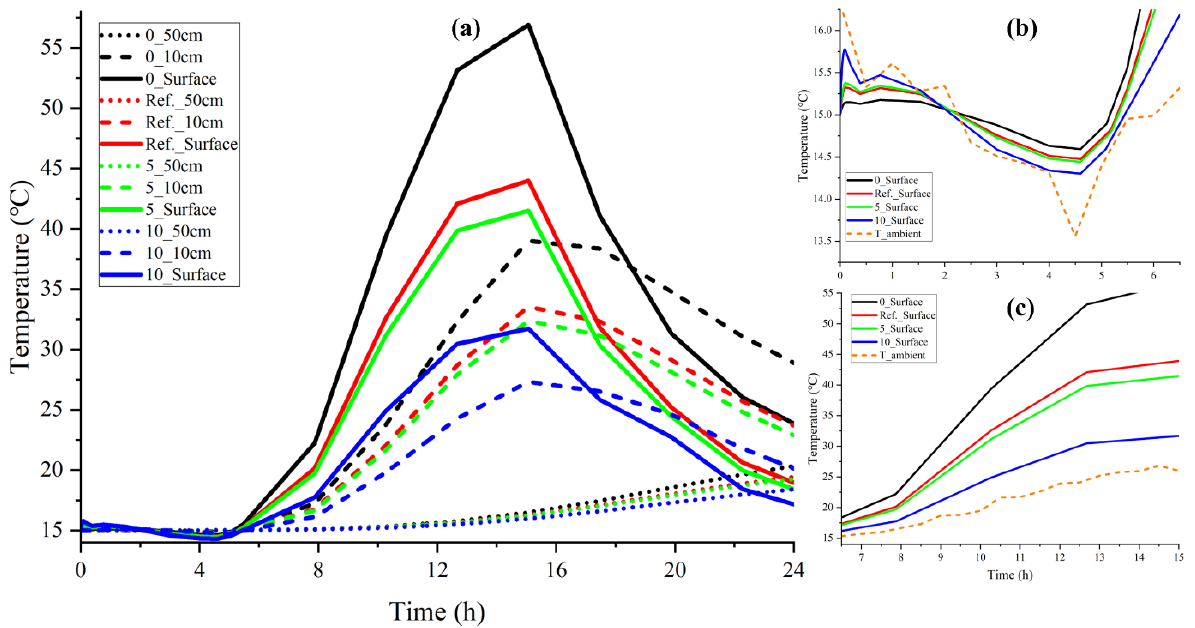
Figure 11. Impact of convection on the temperature distribution (0 m/s set as blank control group): ( a ) three depths: 0 m, 10 cm, and 50 cm; ( b ) surface temperature from 00:00 − 06:00 a.m.; ( c ) surface temperature from 07:00 a.m.–15:00 p.m.